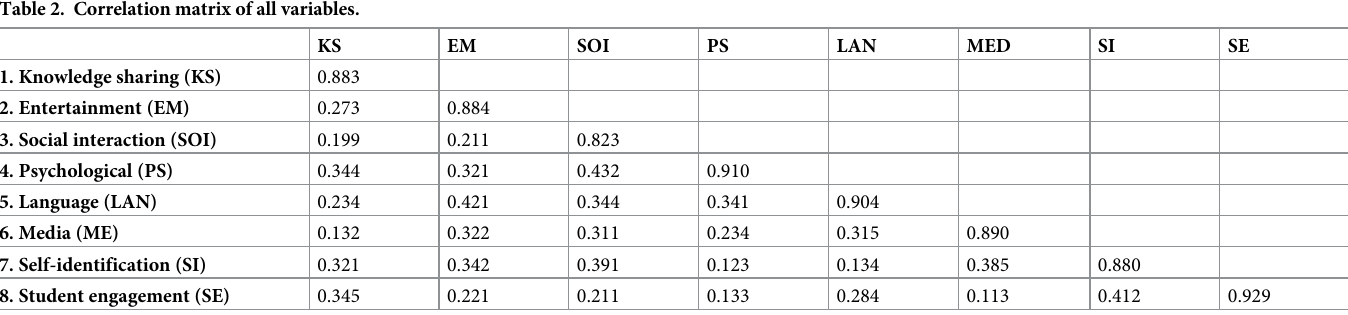
Table 2. Correlation matrix of all